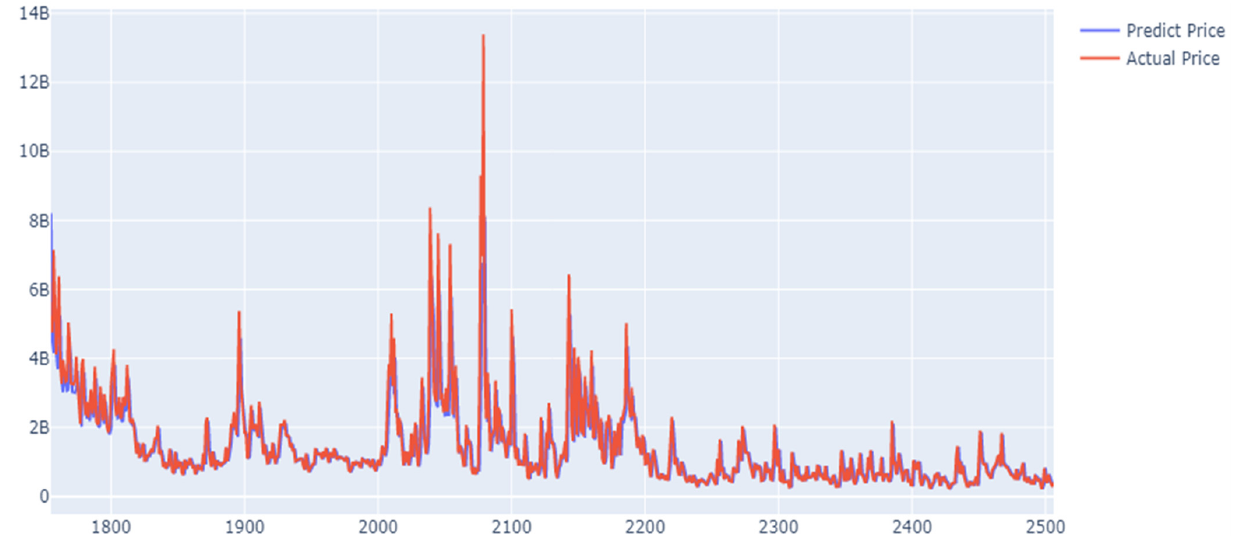
Table 10. Results of the XRP data set for the last 15 days.